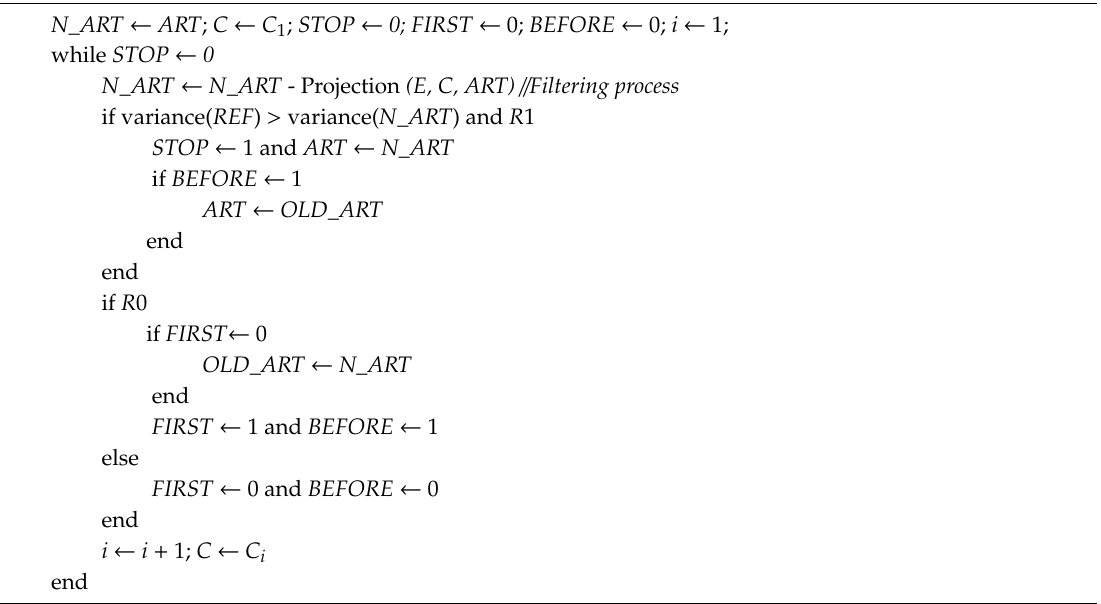
Algorithm 1. The filtering process with the electrode